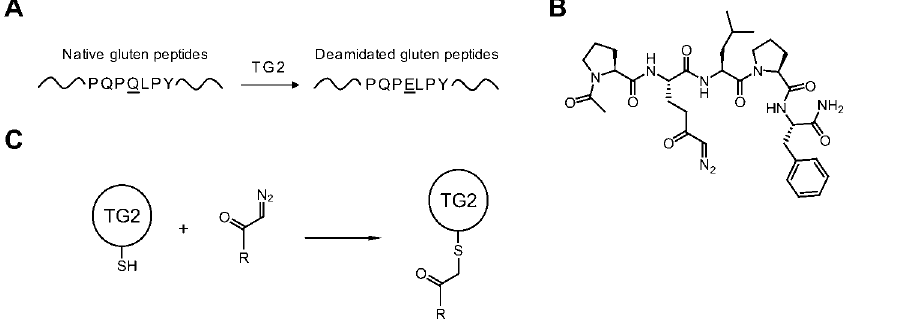
Figure 2. Inactivation of TG2 by a Reactive Gluten Peptide Mimic (A) In the pathogenesis of celiac sprue, TG2 deamidates specific Gln residues in gluten peptides to Glu. (B) The inhibitor Ac-P(DON)LPF-NH 2 mimics a gluten peptide sequence that has high affinity for TG2. DON is the electrophilic amino acid 6-diazo-5-oxo norleucine. (C) The active-site Cys residue of TG2 nucleophilically attacks DON, resulting in a stable thioether adduct.